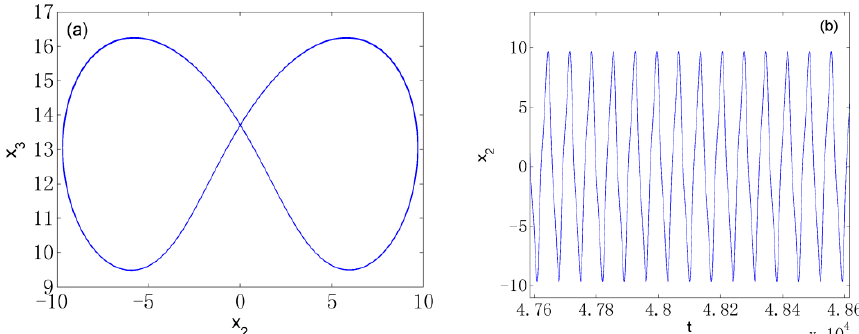
Figure 3. Periodic attractor of system (2) when 𝑐 (cid:3404) (cid:3398)11. ( a ) Phase portrait; ( b ) time evolution curve.